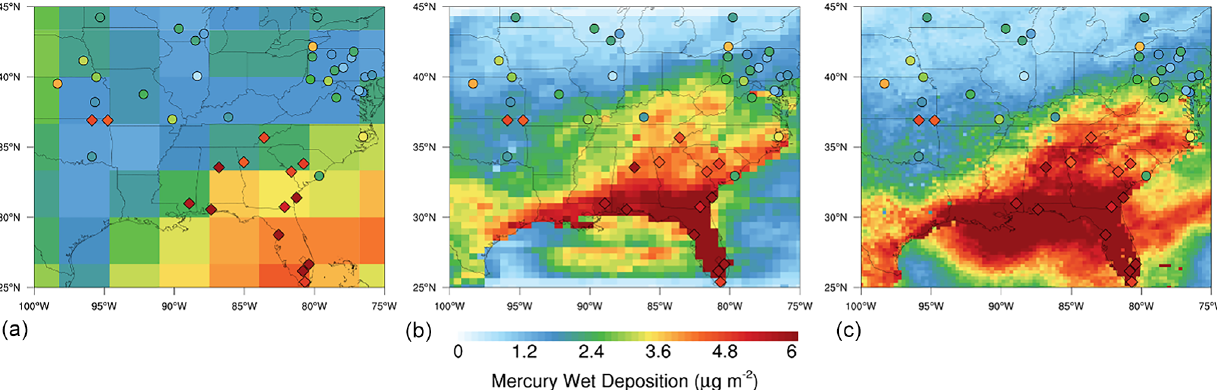
Figure 5. Comparison of total Hg wet deposition by different model simulations from July to September 2013. Panel (a) is GEOS-Chem 4 ◦ × 5 ◦ simulation. Panels (b) and (c) correspond to different WRF-GC resolutions: 50km × 50km and 25km × 25km. The circles represent